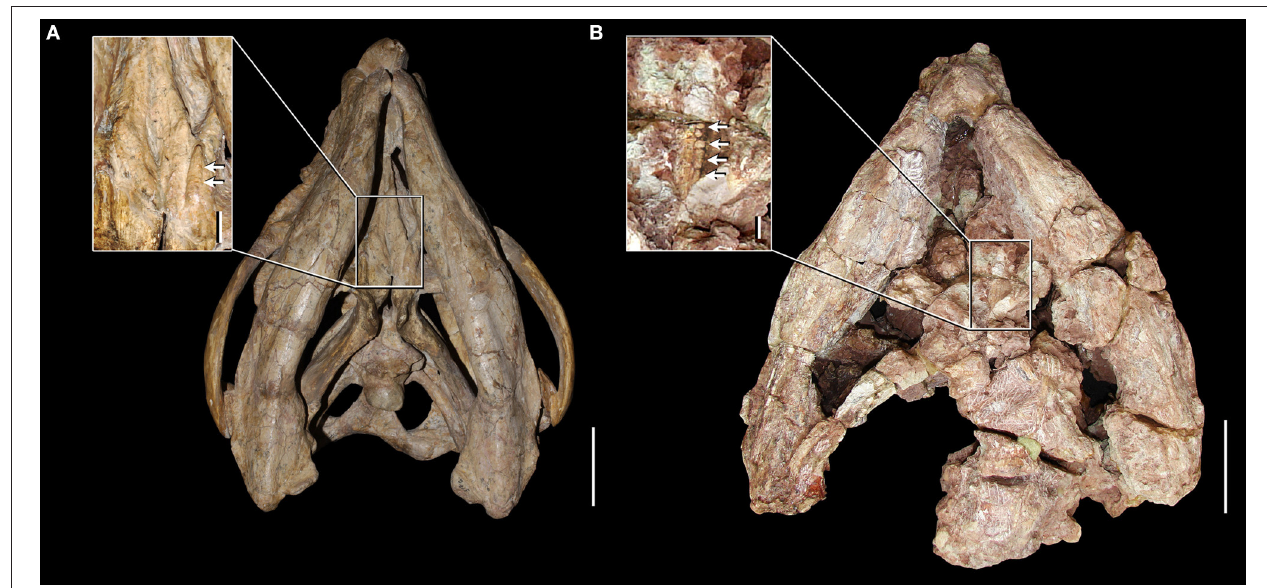
FIGURE 4 | Skulls and close-ups of the palatal morphology in ventral view of Stenaulorhynchus stockleyi from the late Anisian of Tanzania. GPIT/RE/7192 (A) and NHMUK PV R2270 (B) . Arrows indicate pterygoid teeth. Scale bars equal to 5cm in (A,B) , 1cm in close-up of (A) , and 5mm in close-up of (B)